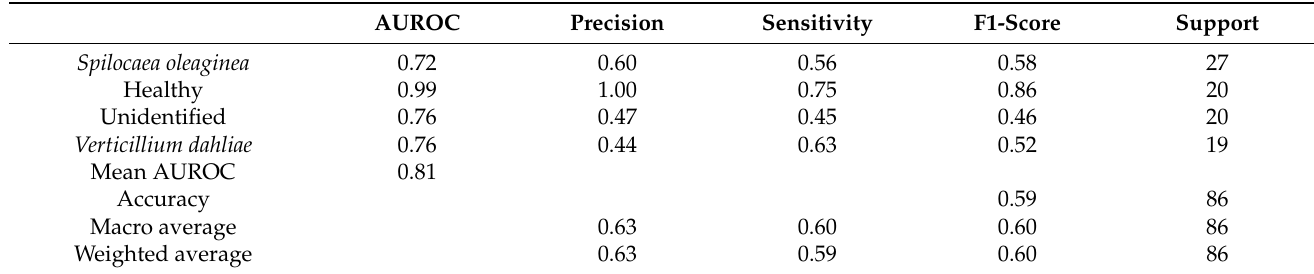
Figure 12. Confusion matrix for true vs. predicted labels for all classes. Table 4. Performance metrics for the one-vs.-rest multiclass classification model.